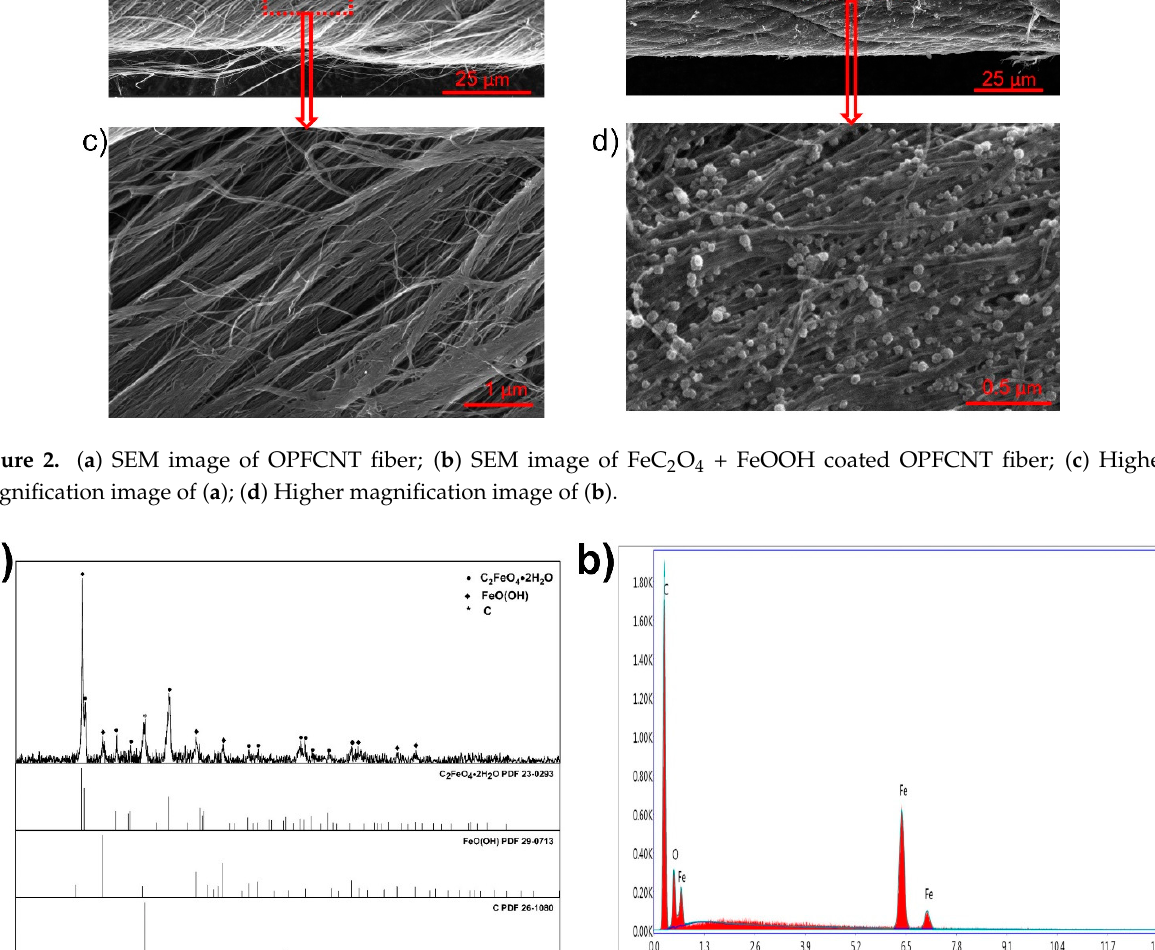
Figure 3. ( a ) XRD pattern of FeC 2 O 4 + FeOOH OPFCNT fiber and ( b ) EDS of FeC 2 O 4 + FeOOH fiber.